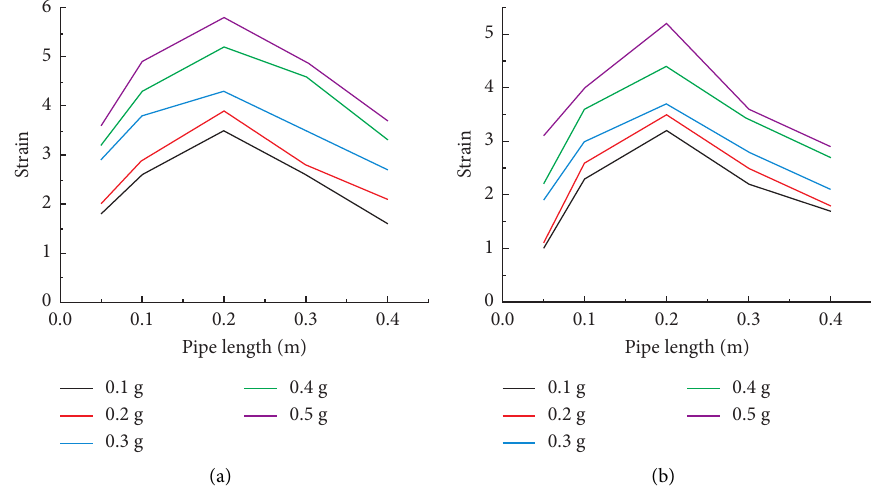
Figure 13: Variation curve of the maximum principal stress value of the bottom plate with the length of the